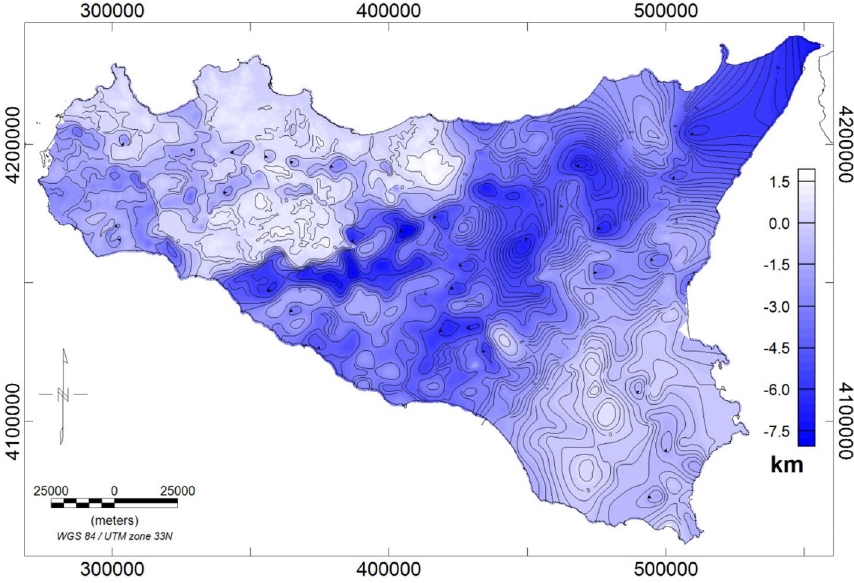
Figure 3. Carbonate top surface of Sicily (meters b.s.l.) obtained from gravity, seismic, and well logs data (modified after 7